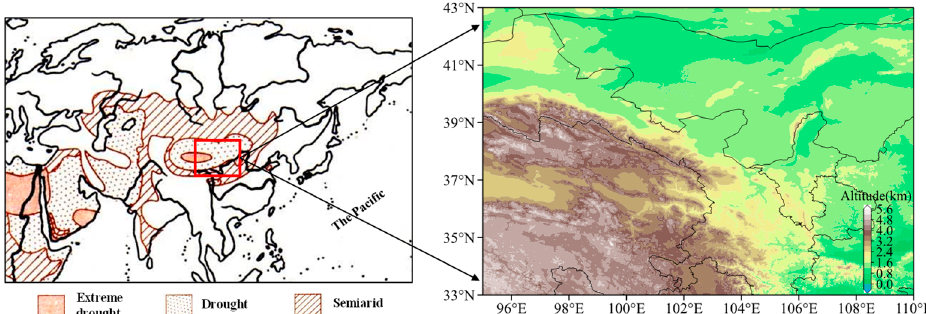
Figure 2. Location of one part (red box) of the semiarid inland Eurasia (SAIE) region, which is situated in the transition zone between semiarid and semi-humid and has experienced paradoxical climate change.